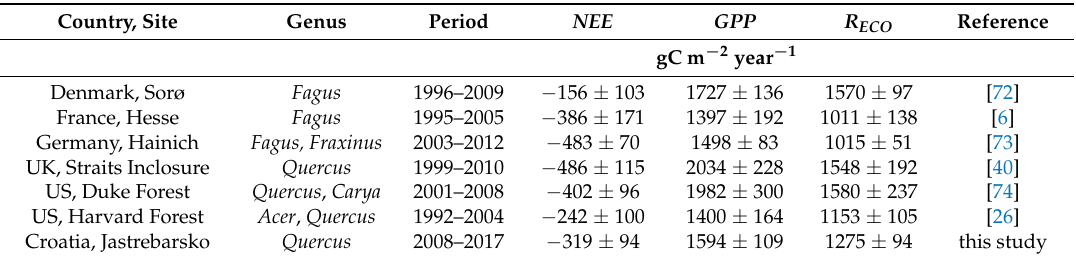
Table 3. Carbon fluxes in temperate deciduous broadleaved forests (average ± standard